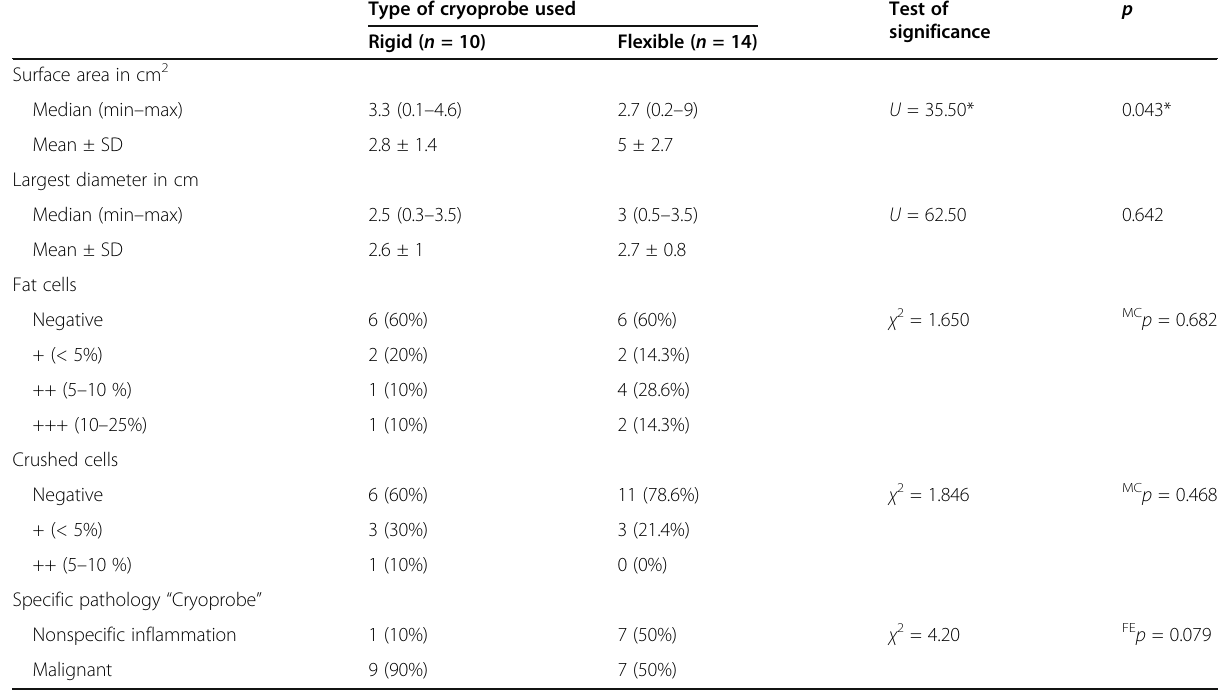
Table 4 Relation between type of cryoprobe used and different parameters ( n = 24)